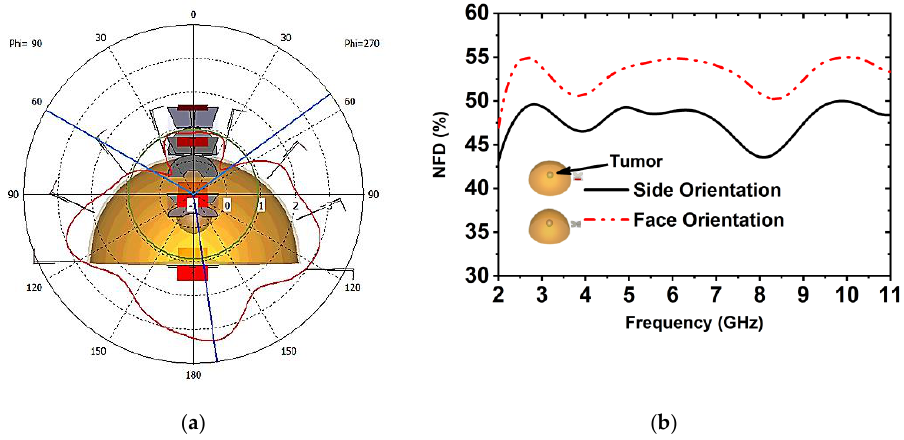
Figure 12. ( a ) Far-field directivity; ( b ) Near field directivity of the imaging setup.